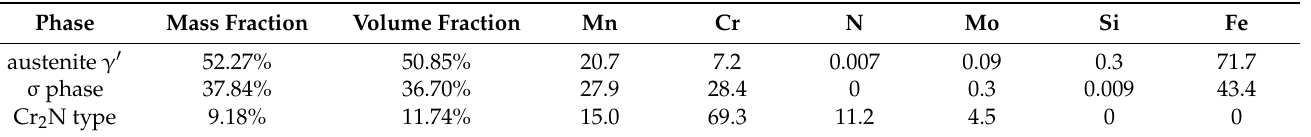
Figure 1. Equilibrium phases at various temperatures according to Thermo-Calc calculations. Black line is FCC austenite γ ’, red line is a trigonal Cr 2 N type phase and blue line is a body-centered tetragonal (BCT) σ phase. Table 2. Composition (wt%), volume, and mass fraction of the main equilibrium phases at 575 ◦ C, obtained from Thermo-Calc calculi with the TCFE9